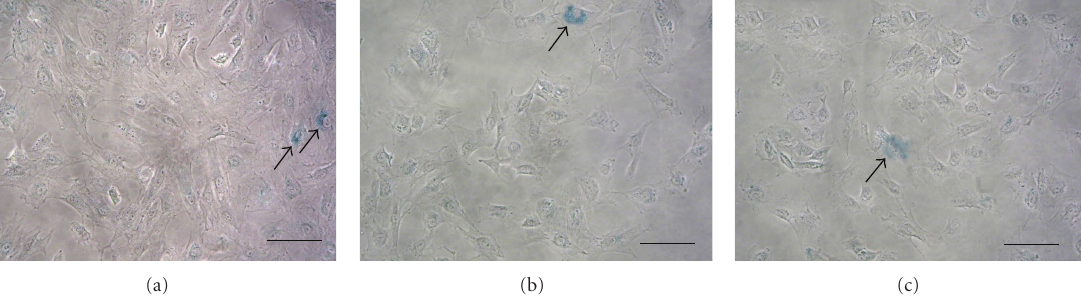
Figure 3: rMSCs senescence. β -galactosidase staining (blue, arrow) of rMSCs at P40 (a), P80 (b), and P140 (c). Bars: 100 μ m.